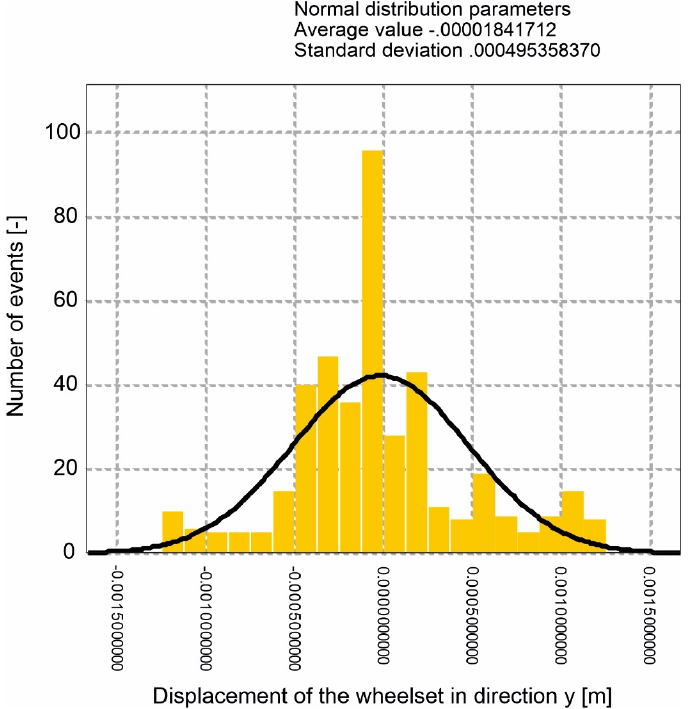
Figure 12. Normal distribution for the displacement of the wheelset in y direction determined for a train crossing the turnout on a straight track with a speed of v = 200 km/h.